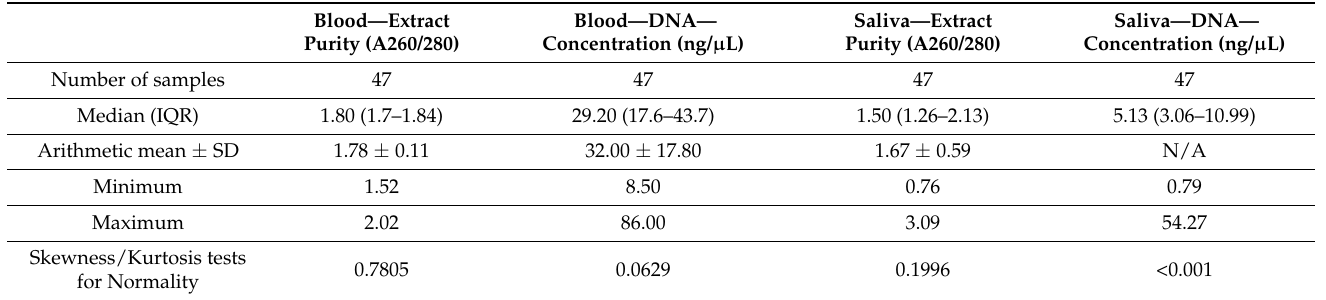
Table 1. Purity and concentration of isolated DNA by students from saliva and blood samples. Blood—Extract Purity